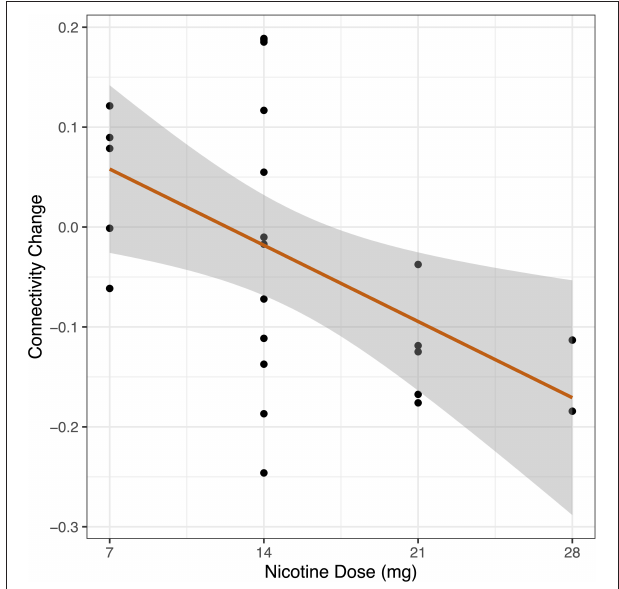
FIGURE 4 | Dose-response relationship between nicotine and DMN connectivity change. In a cohort of schizophrenia and control participants, we measured whole DMN functional connectivity twice: once in the placebo condition and once with nicotine patch. Change in whole DMN functional connectivity was calculated between these two administrations (FC nicotine – FC placebo ). Dosage of nicotine patch varied between individuals based on smoking status (nicotine-dependent, n = 8, range 14–28mg; non-nicotine dependent, n = 16, range 7–14mg). We correlated DMN network connectivity change to administered nicotine dose across the combined sample ( n = 24). We observed a linear relationship between increased nicotine dose and greater reduction in DMN connectivity across the entire sample ( r = − 0.50, p =